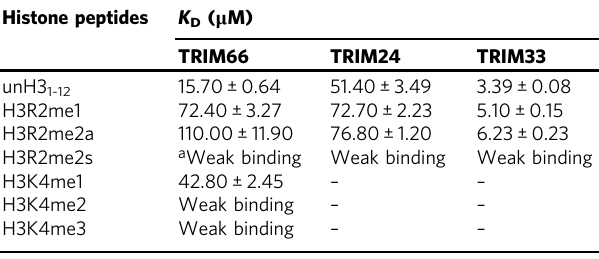
K D values were calculated from single measurement and errors were estimated from fi tting curve by MicroCal PEAQ-ITC analysis software a ITC curves cannot be fi tted reliably